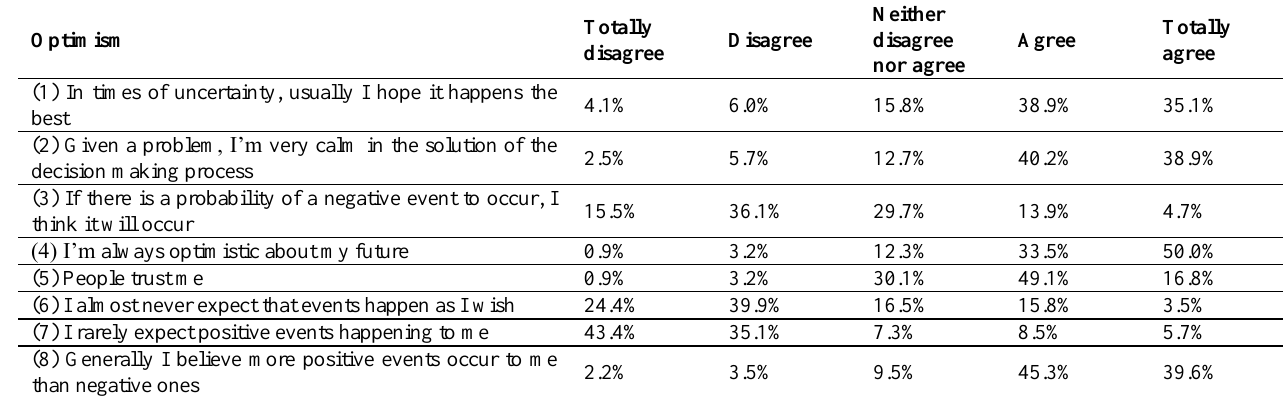
Table 6: Excessive optimism